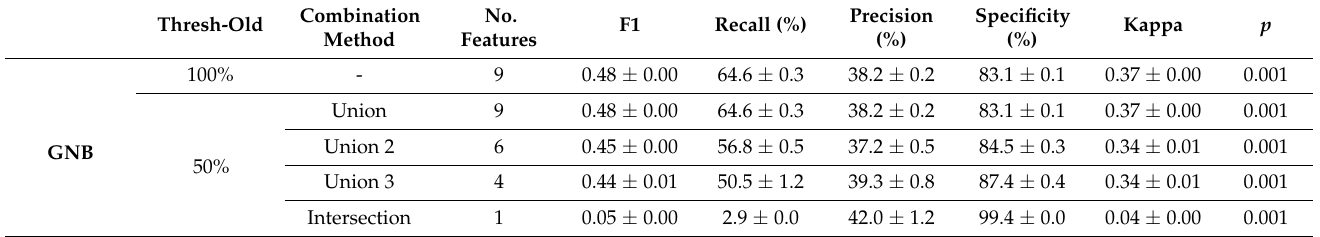
Table A4. Performance of the four classification models on detection fall using Expanded Disability Status Scale data set ; Gaussian Naive Bayes (GNB); Decision Tree (DT); k-Nearest Neighbor (kNN); Support Vector Machine (SVM); p -value via permutation